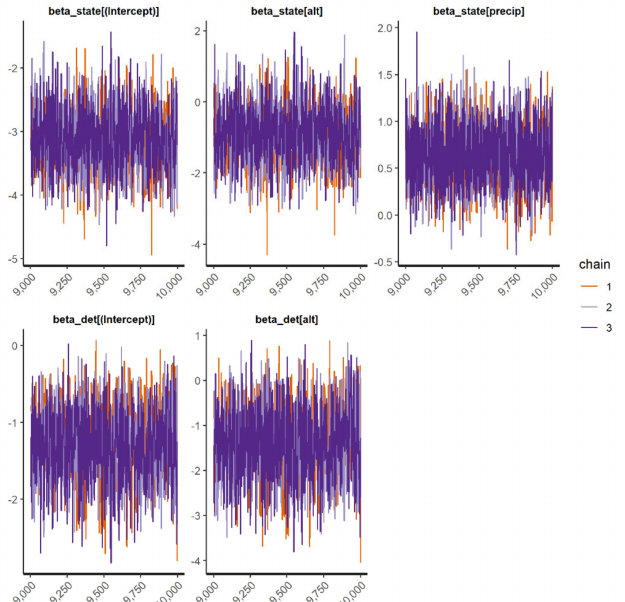
Figure A8. Traceplots from the best occupancy model ( ψ (intercept + elevation + precipitation); ρ (intercept + elevation)) of white-winged parakeet ( Brotogeris versicolurus ) in Puerto Rico. Note: alt = elevation; precip = mean annual